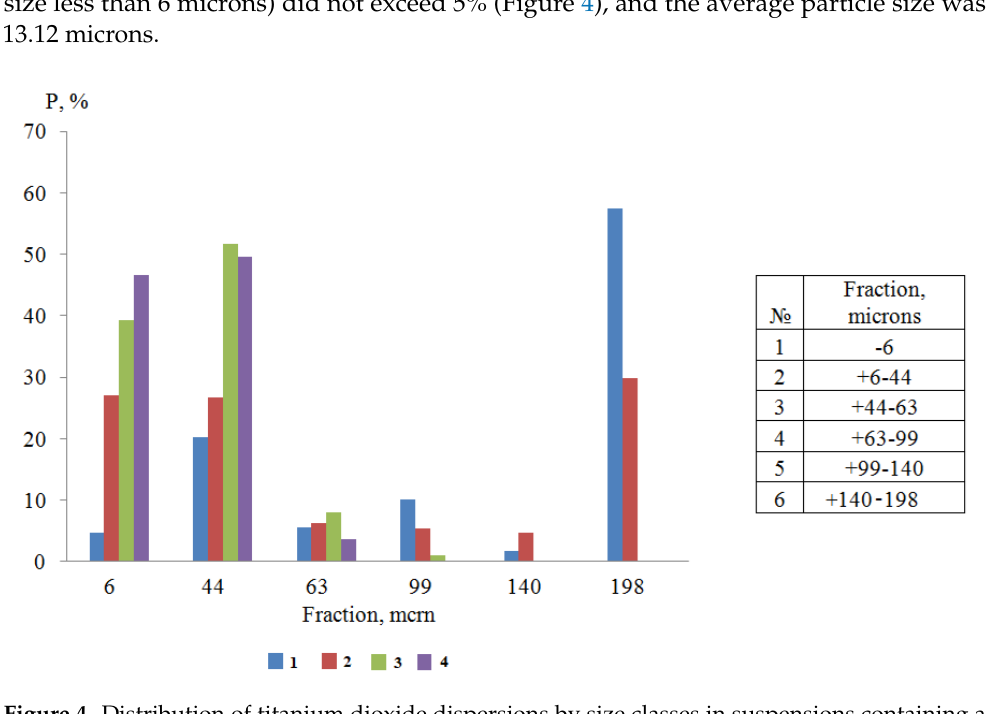
Figure 4. Distribution of titanium dioxide dispersions by size classes in suspensions containing a film-forming agent: 1 — 0%, 2 — 10%, 3 — 20%, 4 — 30%. film-forming agent: 1—0%, 2—10%, 3—20%,